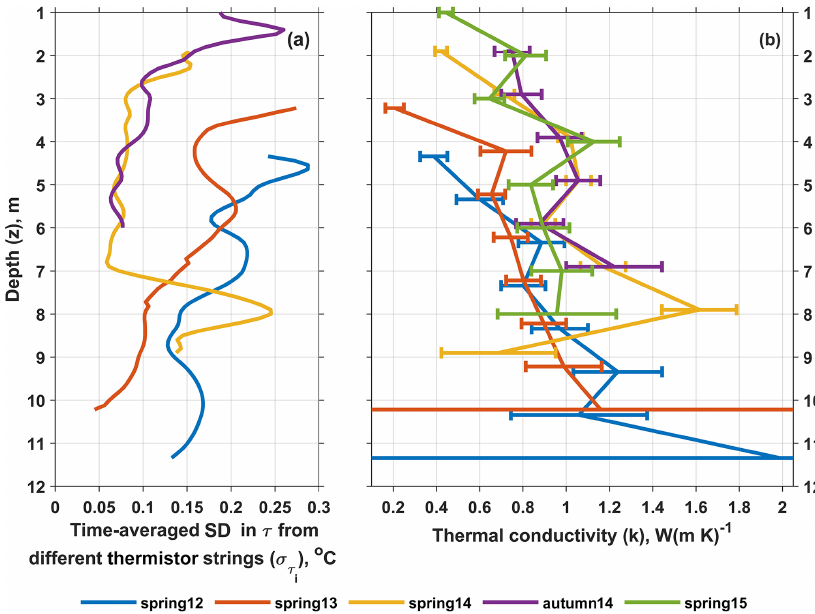
Figure 3. (a) Time-averaged standard deviations in subsurface temperature measured by different thermistor strings ( s i ). (b) Optimized effective thermal conductivity values ( k ∗ ) calculated following Eq. (8) with error bars according to C ov [ δk ] in Eq. (18) assuming temperature errors shown in panel a .